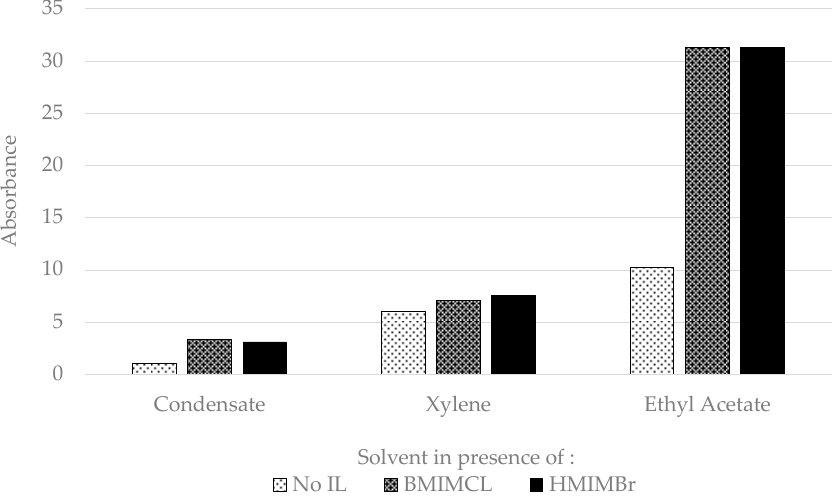
Figure 7. UV-VIS absorbance of extracted solvent with and without the presence of ionic liquid at 0.1 of IL:Wax mass ratio.